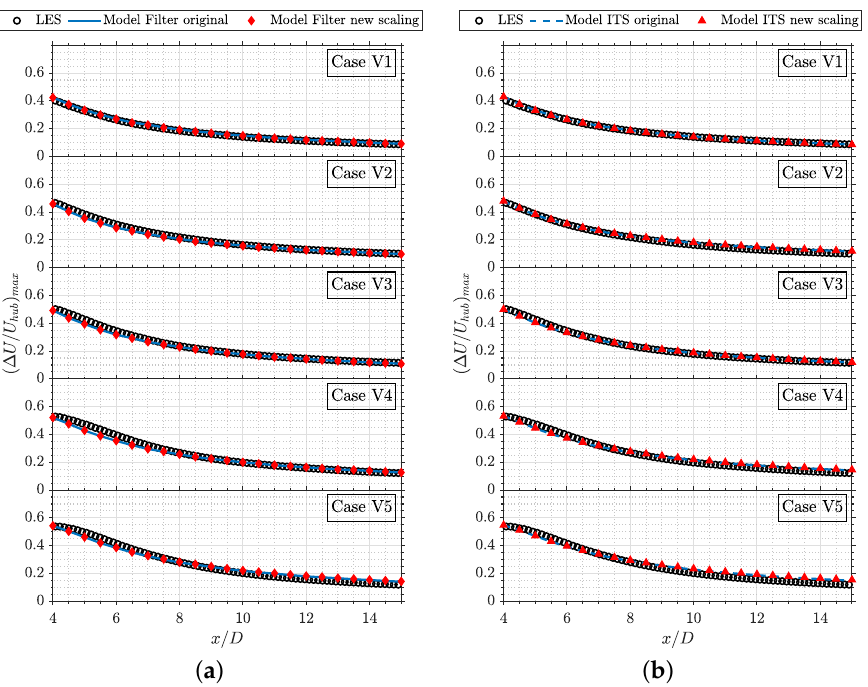
Figure 6. Normalized maximum velocity deficit as a function of streamwise distance. The circles indicate LES results, the lines show the models in their original (iterative) form, and the symbols indicate the model outputs with the new scaling (non-iterative): ( a ) Model Filter and ( b ) Model